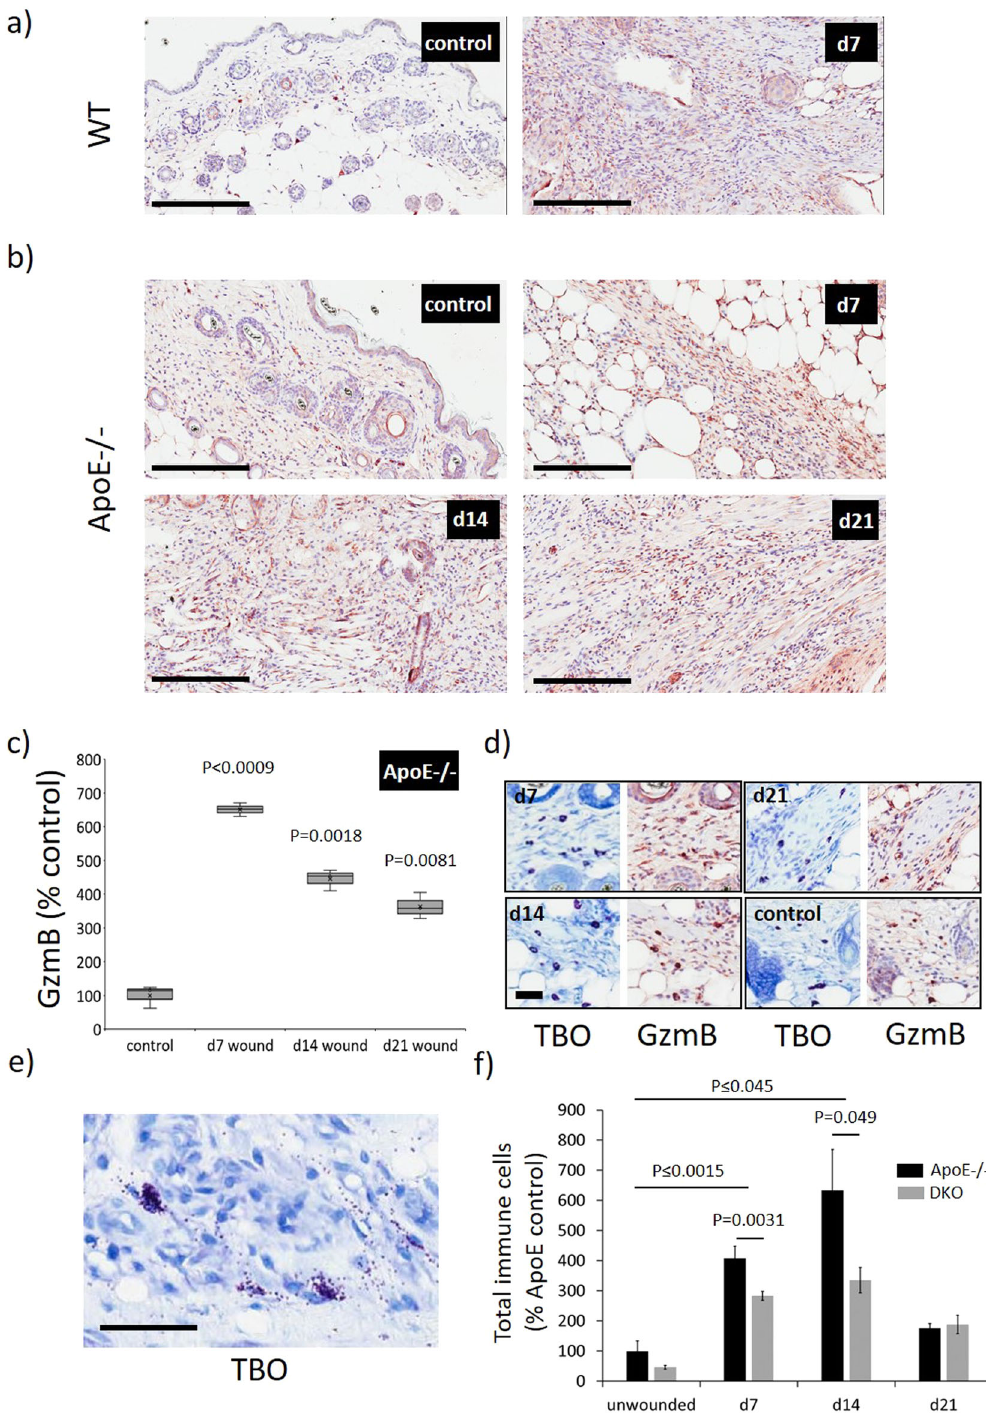
Fig. 3 Elevated GzmB in ApoE − / − mice PI. GzmB immunohistochemistry in WT (a) and ApoE − / − ( b ) mouse PI and unwounded skin controls. Scale bars = 200 µm. c Quanti fi cation of GzmB + cells in ApoE − / − PI and unwounded skin controls. Data presented as the percentage increase of GzmB + cells per area compared to the unwounded control; n = 4 samples per group. Data analyzed by two-way ANOVA with Bonferonni post-test. d TBO (mast cell) stain and GzmB immunohistochemistry on sequential tissue sections. Scale bar = 30 µm. e High magni fi cation image displaying mast cell degranulation in mouse PI tissue at d14 post-injury. Scale bar = 50 µm. f Quanti fi cation of total in fl ammatory cell in fi ltrate in mouse PI as measured from H&E-stained tissue sections. Data analyzed by two-way ANOVA with Bonferonni post-test and presented as total immune cells per unit area as a percentage of the unwounded ApoE − / − control, mean ± SEM ( n = 6 per